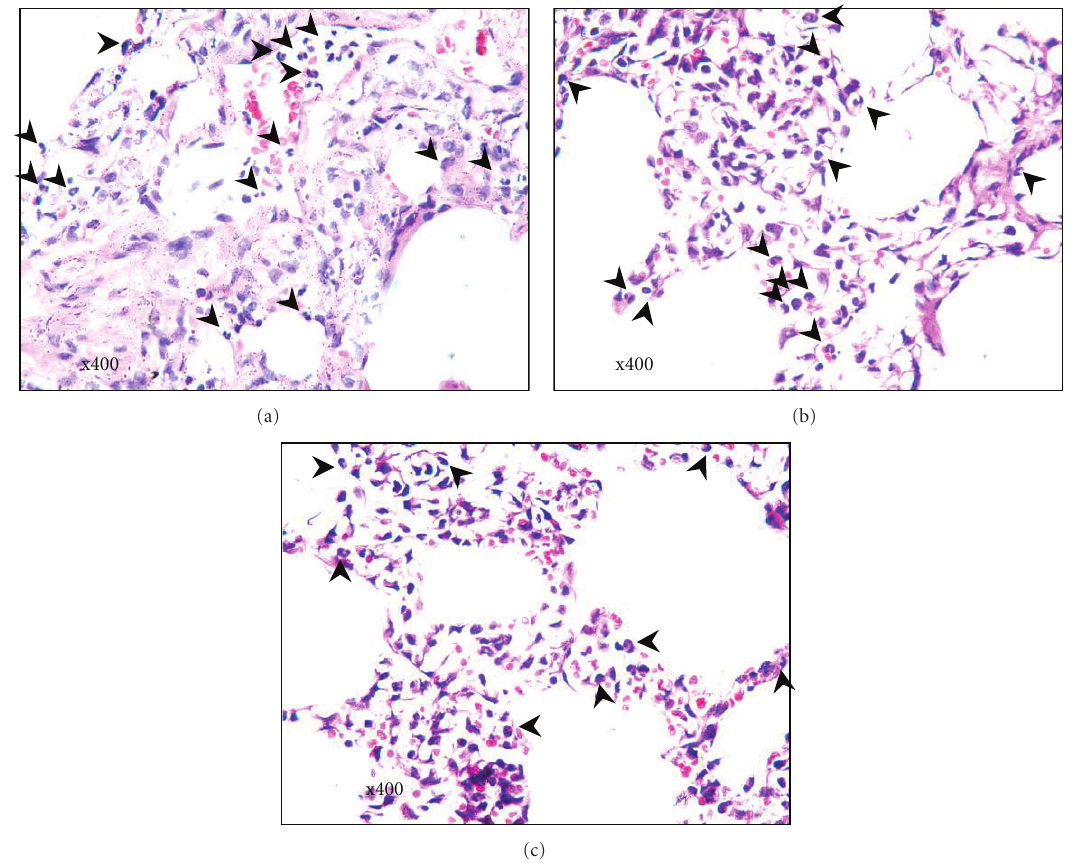
Figure 6: The pathologic changes of lung tissues. Lung tissues from the left-lower lobe underwent routine fixation, dehydration, sectioning, and staining with H&E. General pathological changes of lung tissues were observed by optical microscope. The average neutrophil (arrows) counts were calculated in 10 random high-power fields per section under photomicroscope (10 × 40). (a) LPS group; (b) sham-LCAP group; (c) LCAP